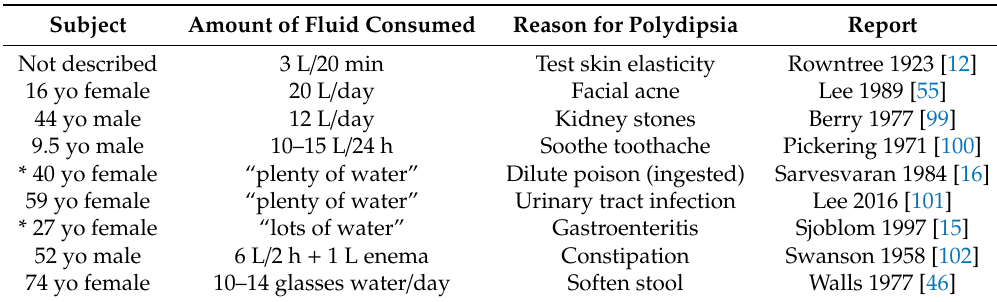
Table 1. Cases of hyponatremic encephalopathy (and death) in otherwise healthy people who overdrank to treat another medical condition (L =